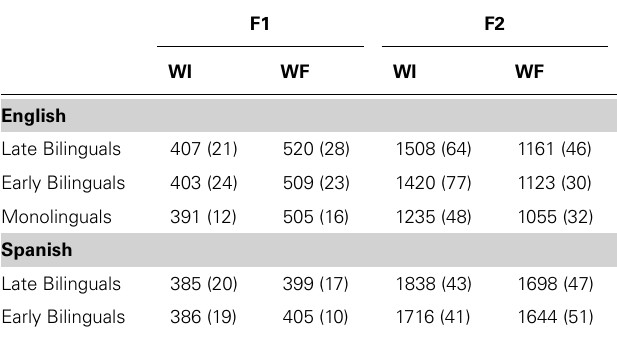
Table 2 | Means (and standard errors) of raw F1 and F2 values for English and